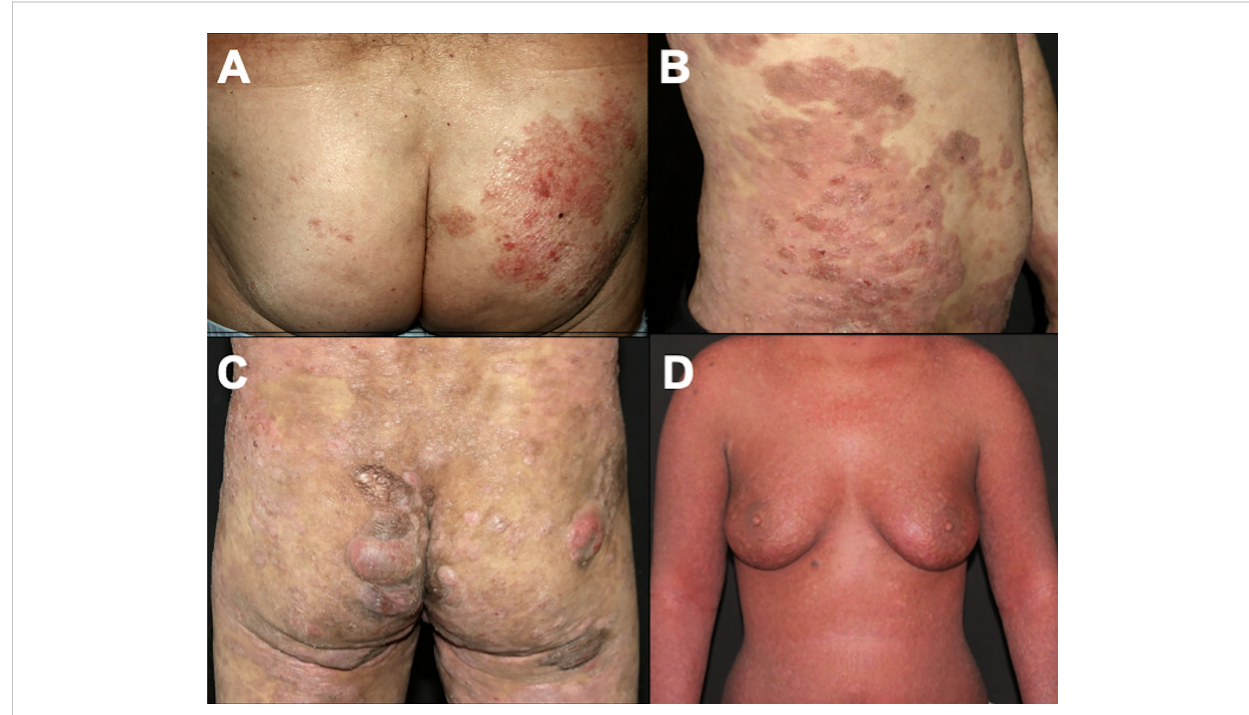
FIGURE 1 Clinical presentation of classic MF. Patches on the buttocks (A) ; plaques on the abdomen (B) ; patches, plaques, and tumors on the buttocks (C) ; erythroderma (D)